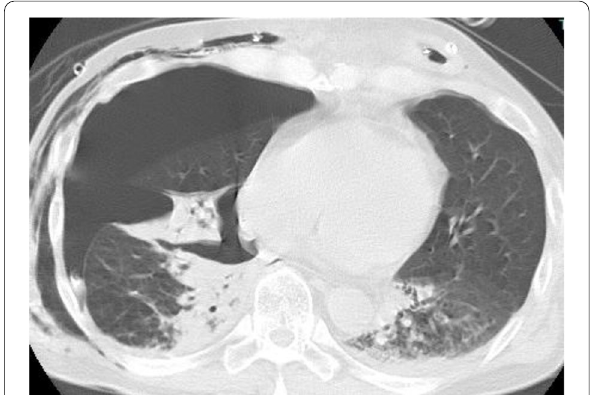
Fig. 1 Chest CT scan. Right advanced pneumothorax and left atelectasis and pneumonia